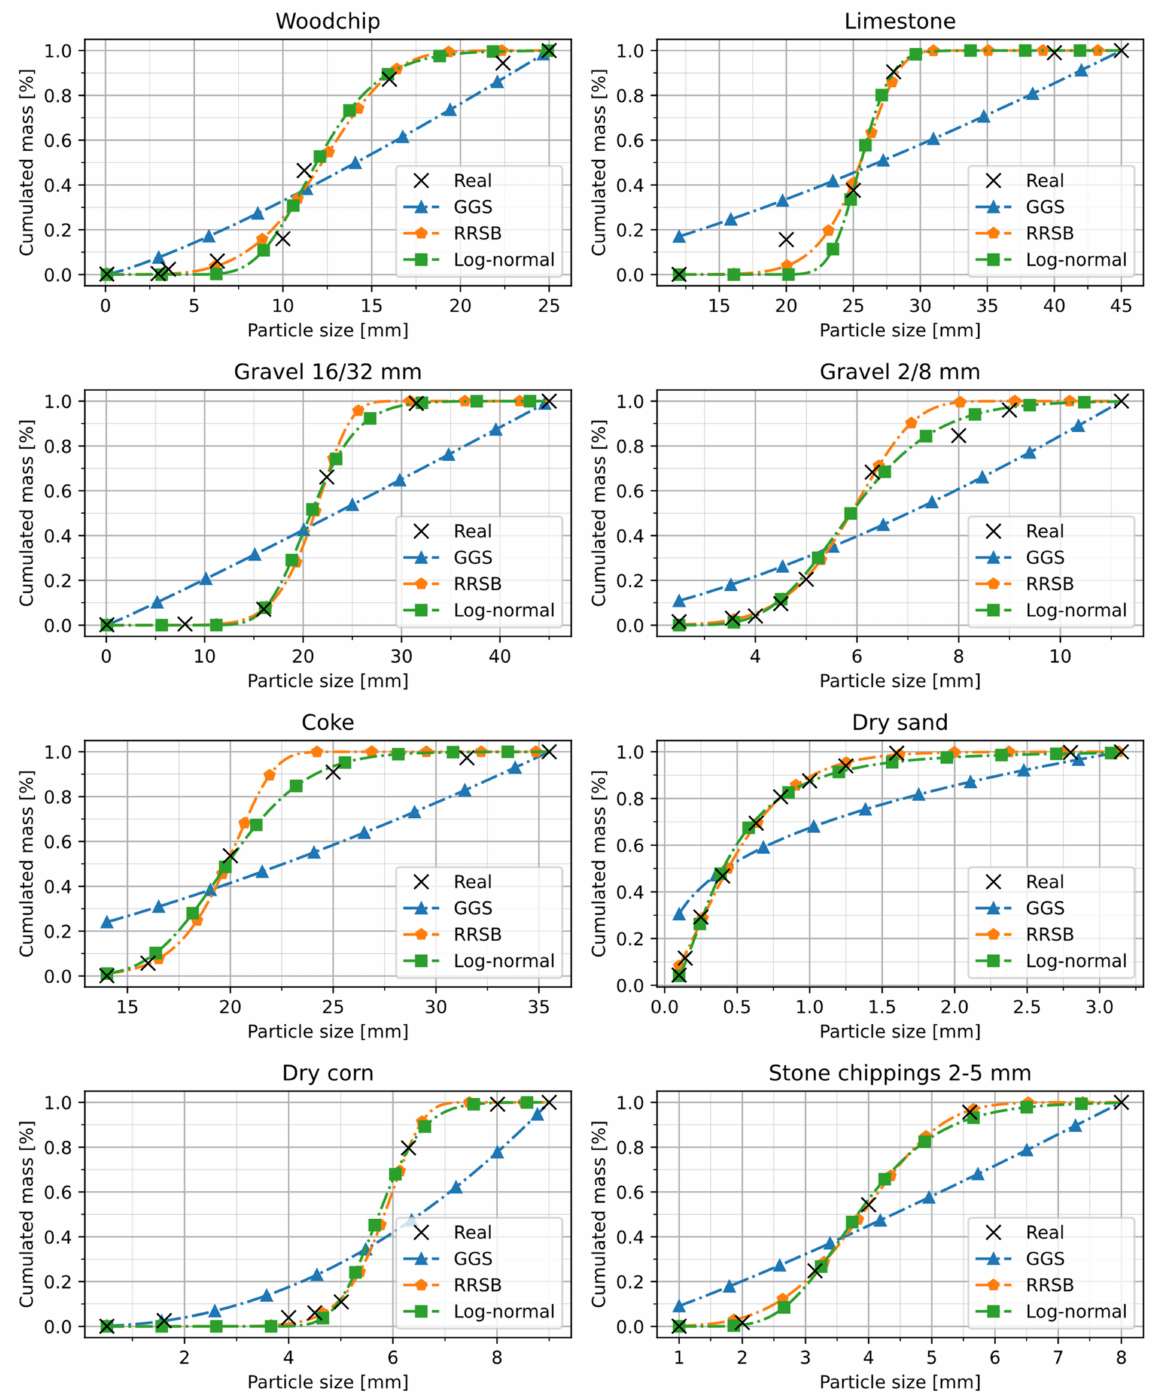
Figure 4. Comparison how good different analytical distributions functions fit the real particle size distribution of the example